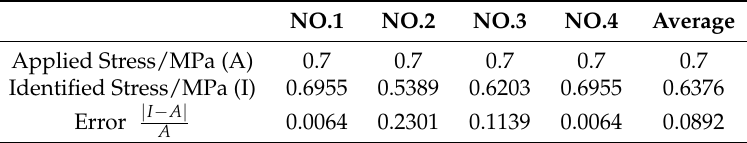
Table 2. The identified load results of No.1–4 Lead Zirconium Titanate (PZT) chips in the same depth (10